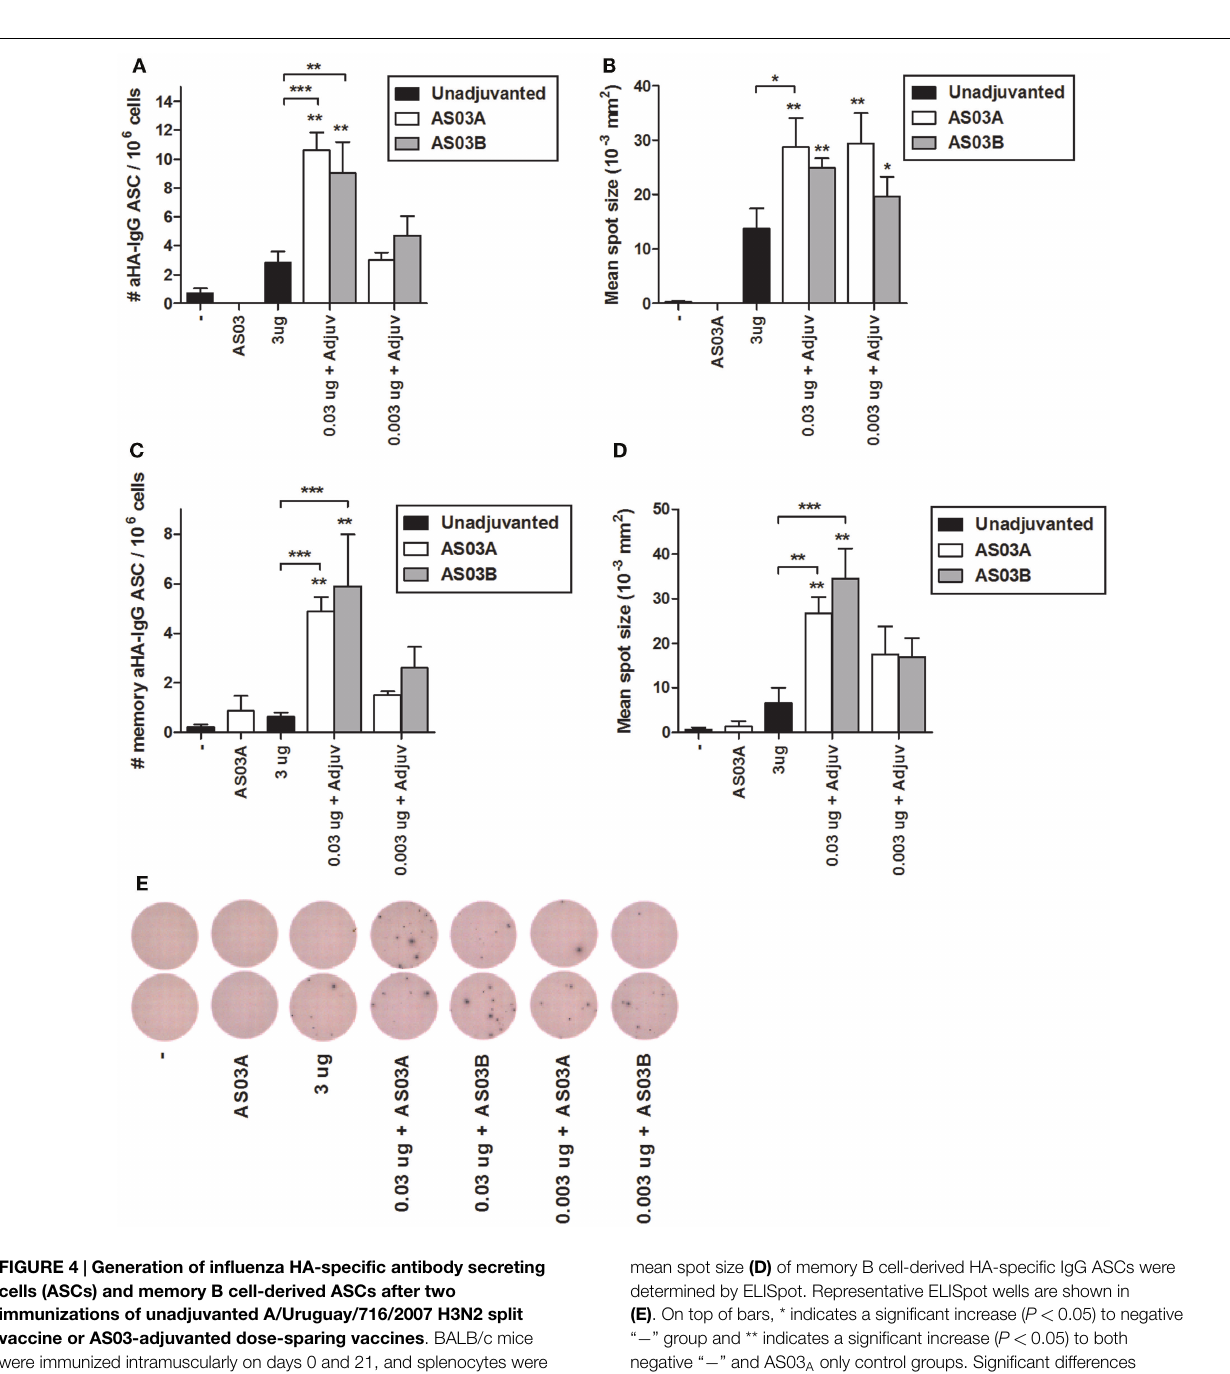
mean spot size (D) of memory B cell-derived HA-specific IgG ASCs were determined by ELISpot. Representative ELISpot wells are shown in (E) . On top of bars, * indicates a significant increase ( P < 0.05) to negative “ − ” group and ** indicates a significant increase ( P < 0.05) to both negative “ − ” and AS03 A only control groups. Significant differences between groups are denoted by brackets; * P < 0.05; ** P < 0.01; *** P < 0.001. Data represent mean and SEs of 4–12 mice per group combined from two independent